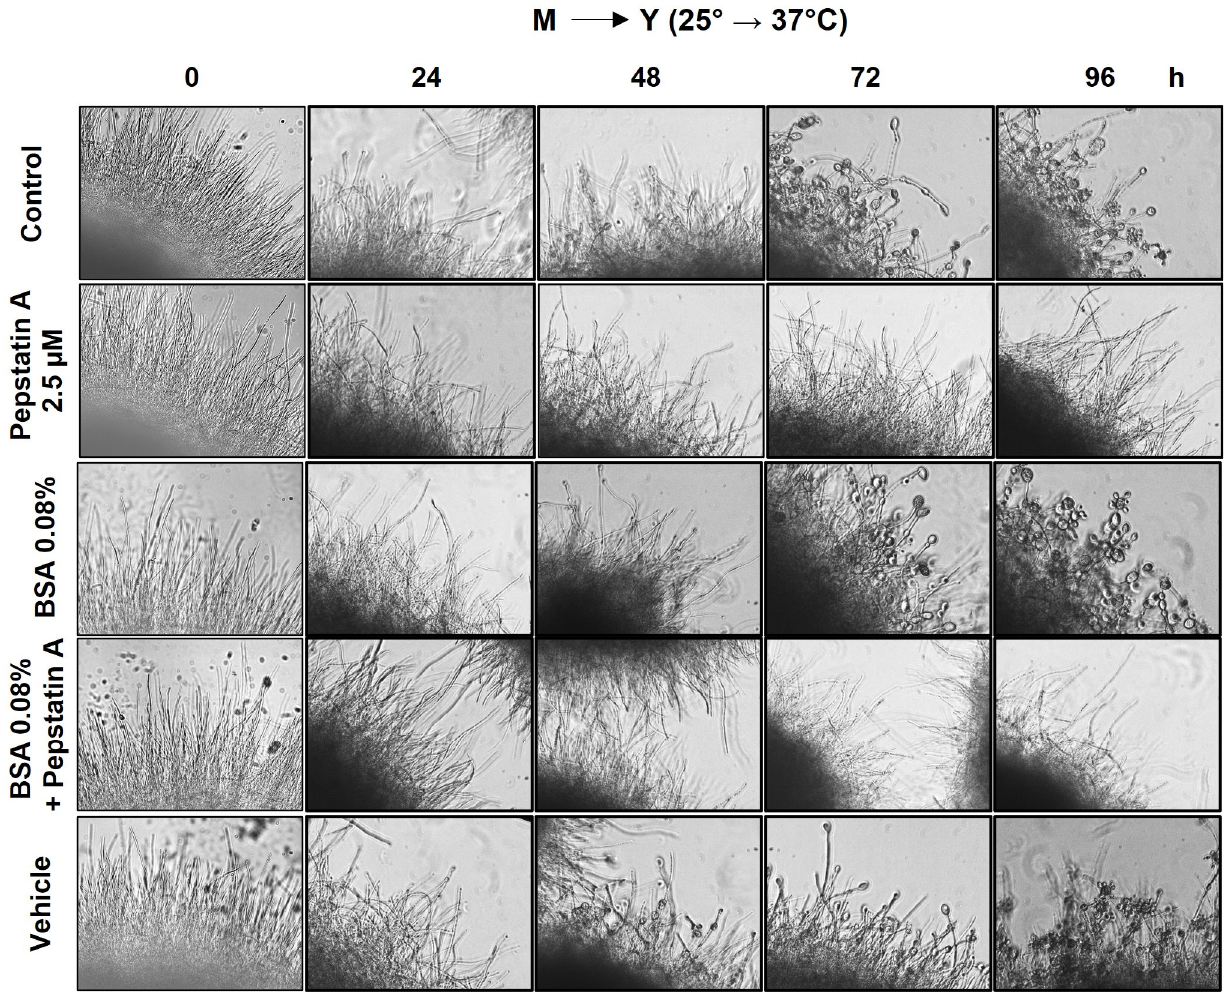
Figure 2. Aspartic proteases are involved in the transition from mycelium to yeast in Paracoccidioides brasiliensis . Mycelial cells growing in the early exponential phase were induced to undergo morphological transformation by changing the temperature of incubation. Paracoccidioides brasiliensis mycelium cells were treated in the presence or absence of DMSO (vehicle), Pepstatina A (2.5 µM), and BSA (0.008% w / v ) and incubated at 37 °C for 4 days. After 48 h incubation, the mycelium cells started to differentiate into yeast in untreated (control) and DMSO-treated cells, but not in cells treated with 2.5 µM Pepstatin A. The results shown are representative of three independent experiments.